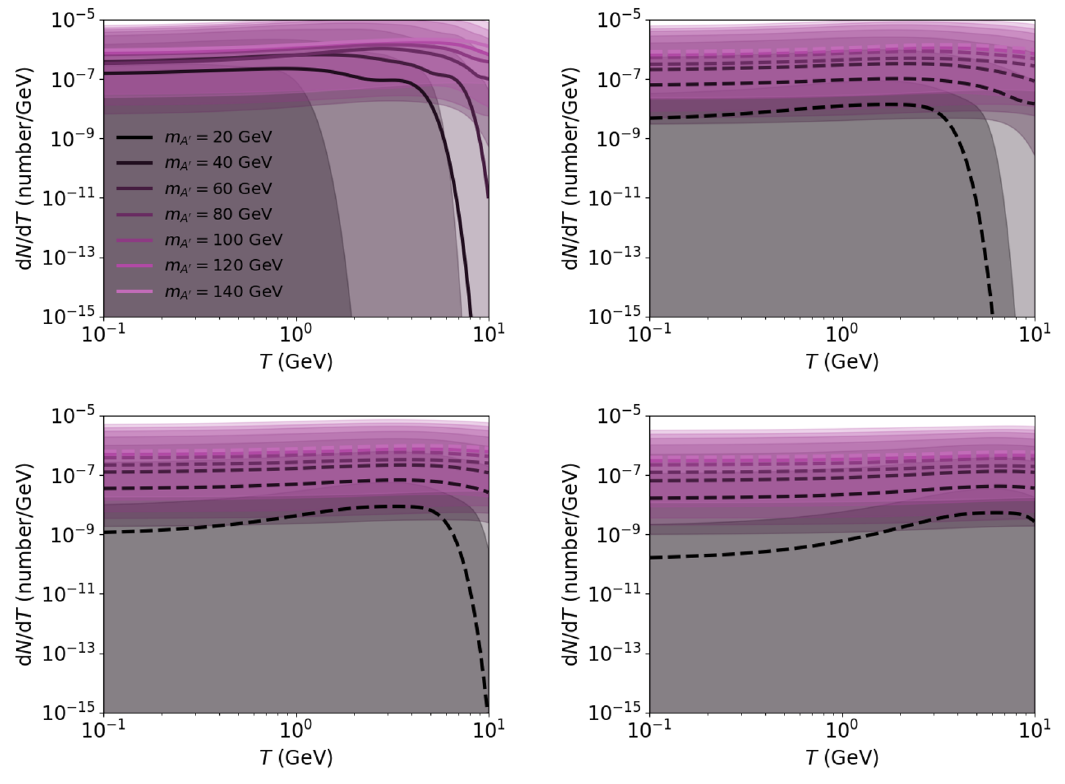
Figure 11. Injection spectra of antihelium for various dark photon masses, boosted to the rest frame of DM assuming m A 0 =m (cid:31) = 1 (top left), 2 = 3 (top right), 1 = 2 (bottom left), and 1 = 3 (bottom right). The line is evaluated at p 0 = 225 MeV and the shaded regions denote the range of injection spectra given by 125 (cid:20) p 0 (cid:20) 325